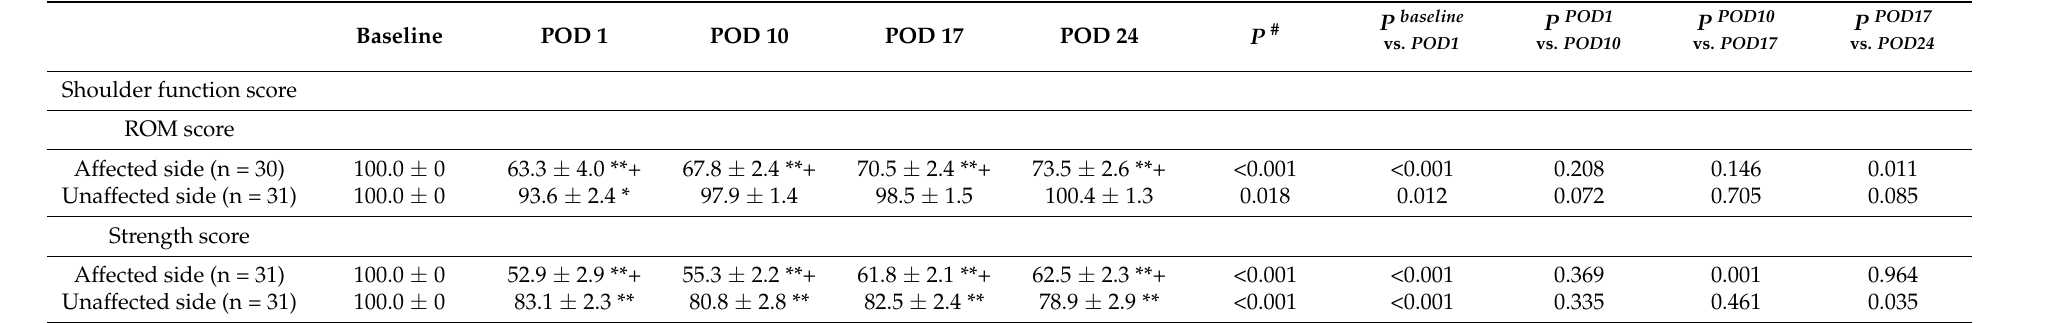
Table 4. Change of shoulder function score (pre-surgery to 4 weeks